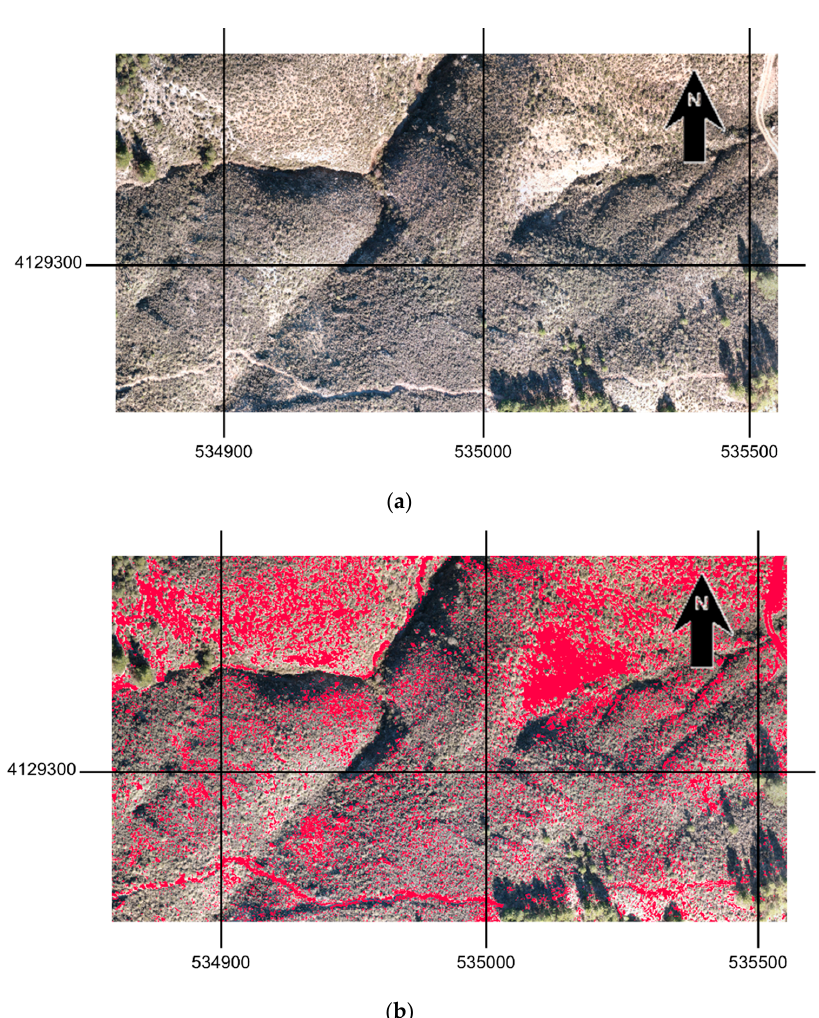
Figure 9. ( a ) Detail of the RGB orthoimage composition; ( b ) non-vegetation points detected by masking the dense point cloud with a threshold NDVI map.